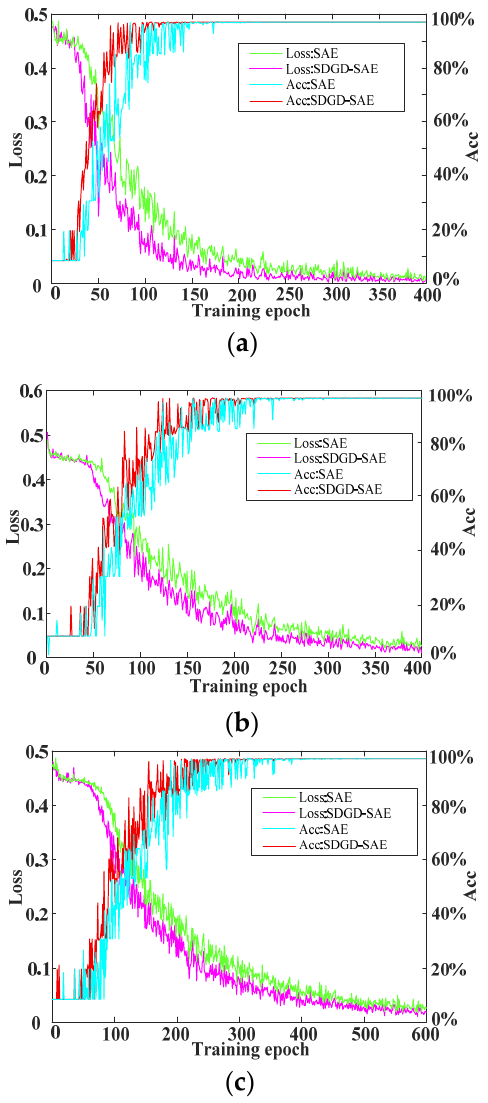
Figure 11. Convergence speed comparison ( a ) BatchSize = 40 ( b ) BatchSize = 50 ( c ) BatchSize = 100 . Table 10. Convergence speed comparison.